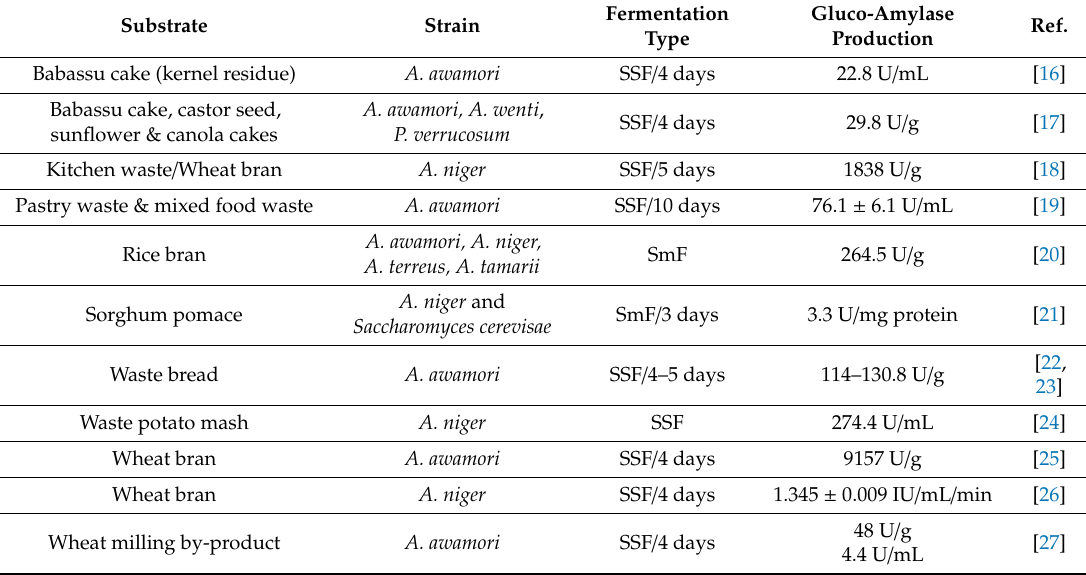
Table 1. Recent studies on glucoamylase production via fungal